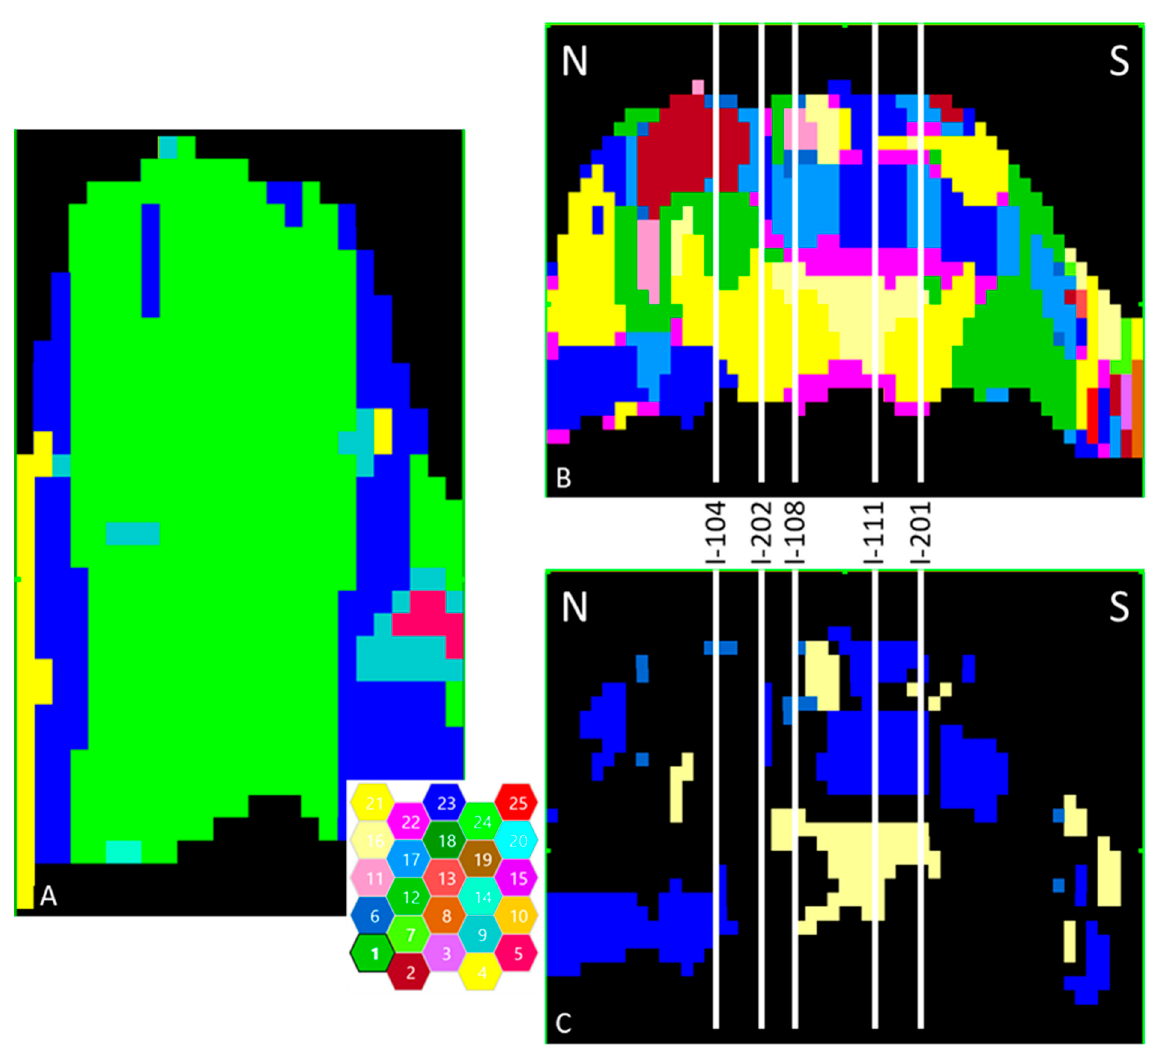
Figure 8. ( A ) shows the frequency SOM results for the Lenox reef at inline 56. The reef zone is dominated by neurons 23 and 24. ( B , C ) are images are of the Ira reef frequency SOM results at crossline 58. ( B ) is with all the neurons displayed, while ( C ) is only displaying the neurons of interest. The five vertical white lines are wells on crossline 58. Wells I-201, I-111, and I-108 are the top three ranked wells in the field, while wells I-104 and I202 were ranked ninth and twelfth out of twelve.